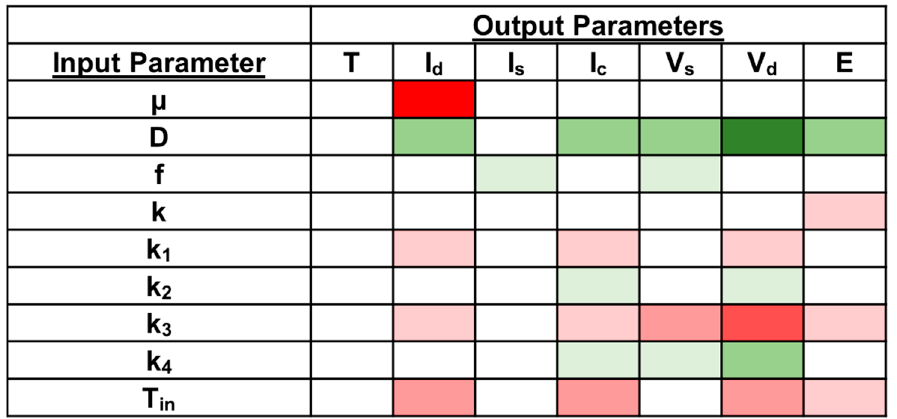
Figure 5. Sensitivity analysis: The figure above shows a correlation heat map representing the sensitivity analysis results. The colors in the map indicate negative (red) correlation or positive (green) correlation. Darkness of a color indicates a stronger correlation. Therefore, for the growth rate, µ , a 50% change in input had a strong negative impact on the population of DIPs, I d